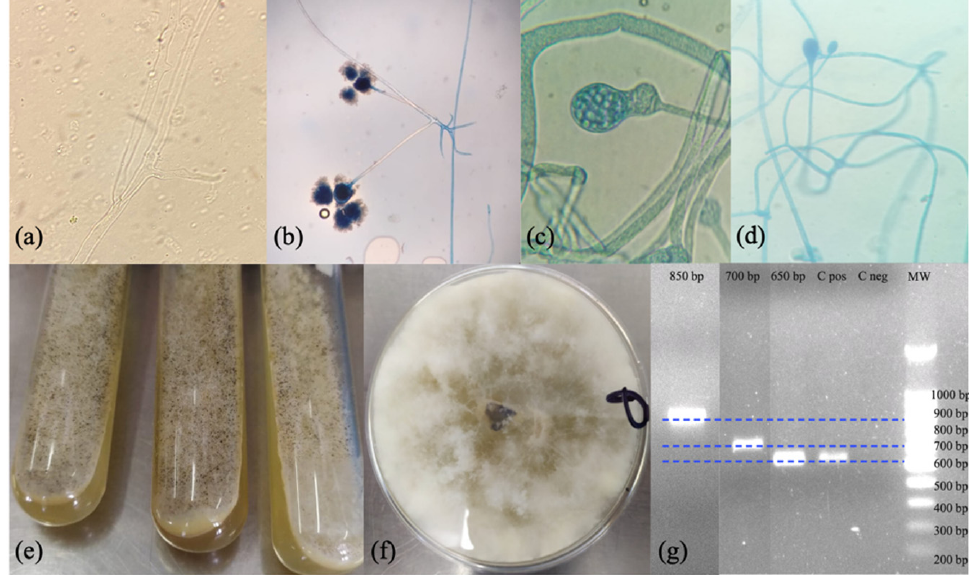
Figure 1. ( a ) Potassium hydroxide (KOH 10%) wet mount showing irregular, wide, and aseptate fungal hyphae. ( b ) Lactophenol cotton blue stain showing Rhizopus sp., 10 × . ( c , d ) Lactophenol cotton blue stain showing Apophysomyces sp. 100 × and 40 × respectively, collected from microcultures. ( e , f ) Growth of white cottony colonies in PDA culture after 5 days of incubation at 28–30 °C. ( g ) Agarose gel electrophoresis of PCR products amplified using primers ITS1 and ITS4 and a 100 bp molecular weight marker (MW). The lines correspond to three different electrophoreses that have been merged into a single image.